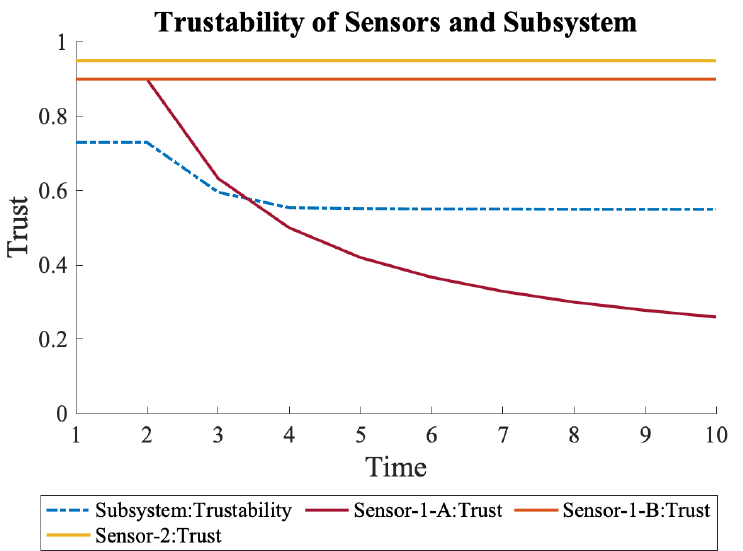
Figure 7. Trustability of System-2 and the sensors. The overall trustability of System-2 is more resistant to the trust surges of the sensors that are connected in